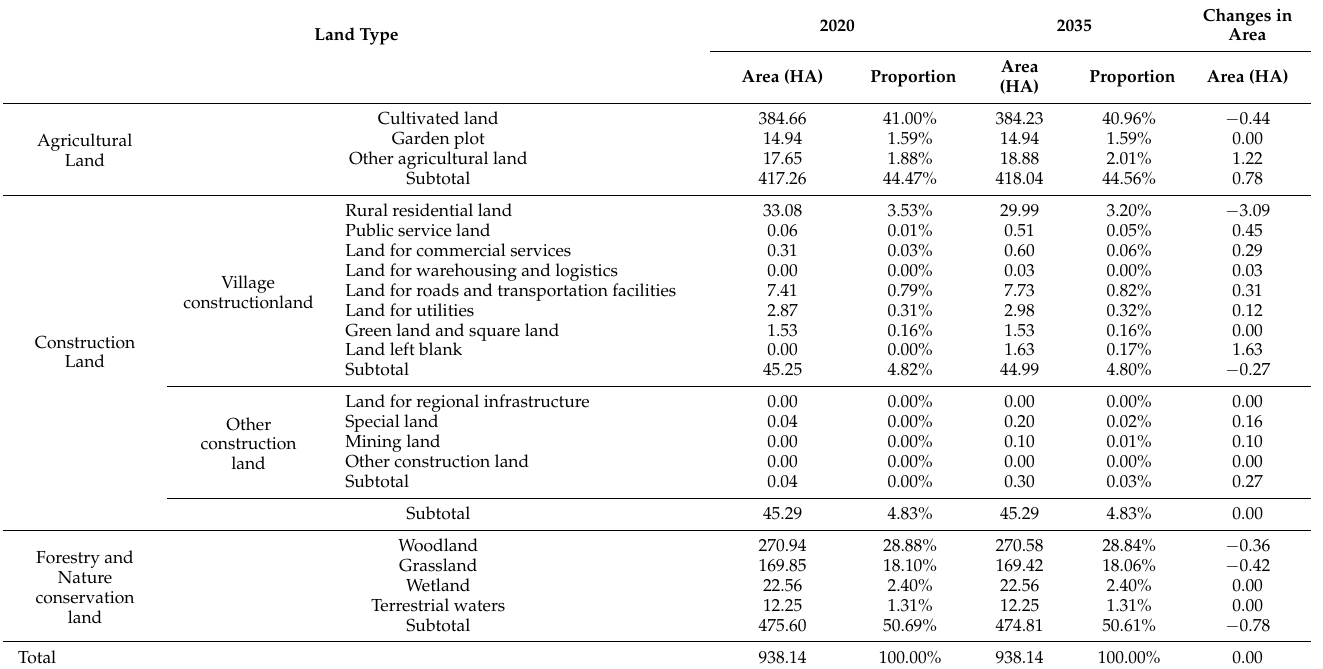
Table 1. Puhe Village land adjustment